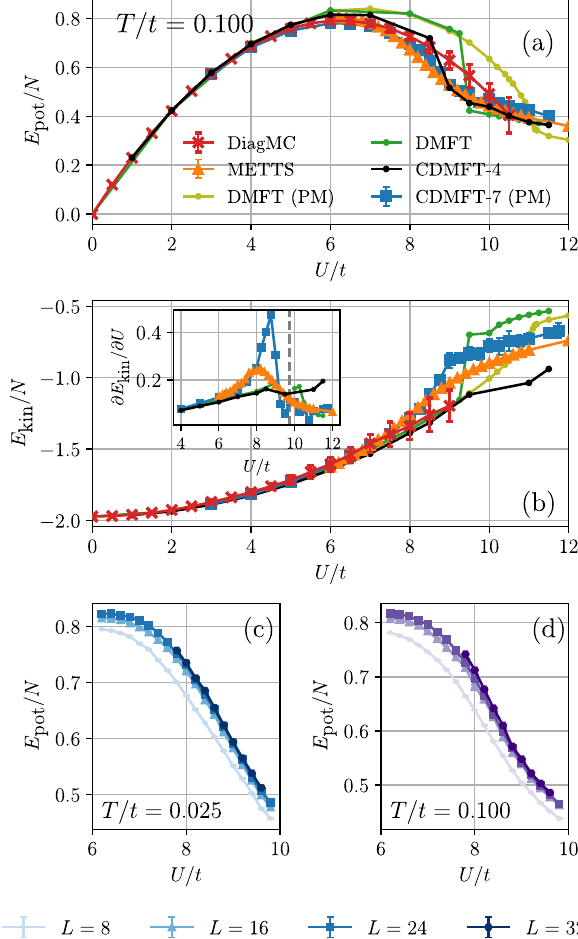
FIG. 3. Comparison of energies from different computational methodsat T=t ¼ 0 . 1 .METTSresultsareobtainedona 16 × 4 YC4 4000 ,clusterDMFTisperformedona 7-site cylinderwith D max ¼ cluster [restricted to its paramagnetic solution, CDMFT-7 (PM)] and on a 4-site cluster (allowing for spin-symmetry breaking, CDMFT-4), while DiagMC is numerically exact within the esti- mated error bar. (a) Potential energy E . METTS and cluster pot DMFTagreewiththeDiagMCresultsupto U=t ≈ 7 . 5 .Beyondthis point we find excellent agreement between cluster DMFT and METTS. (b) Kinetic energy E . We observe good agreement pot between all methods up to U=t ¼ 8 . The inset shows the derivative ofthekineticenergywithrespect tothecouplingstrength U .(c),(d) The potential energy density from METTS as a function of cylinder length L at temperatures T=t ¼ 0 . 025 and T=t ¼ 0 . 100